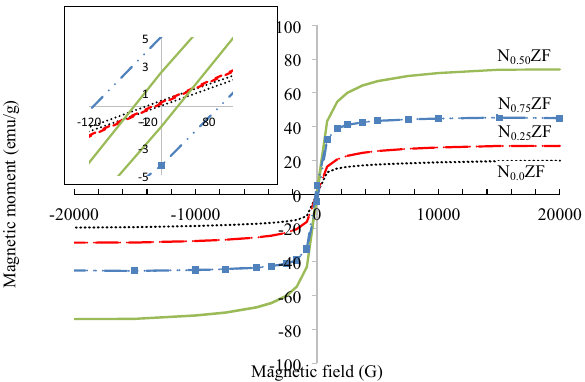
Figure 9. Magnetic hysteresis loops for the prepared NZF samples.